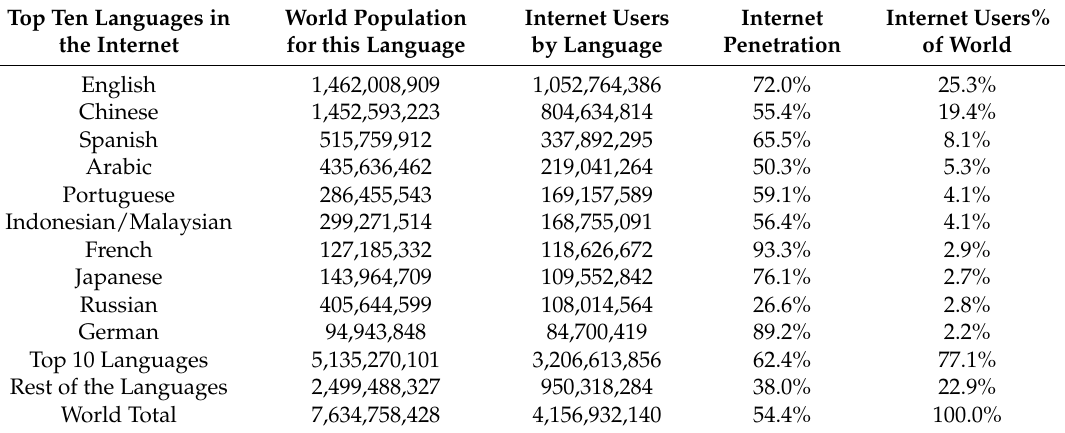
Table 1. Top ten languages on the